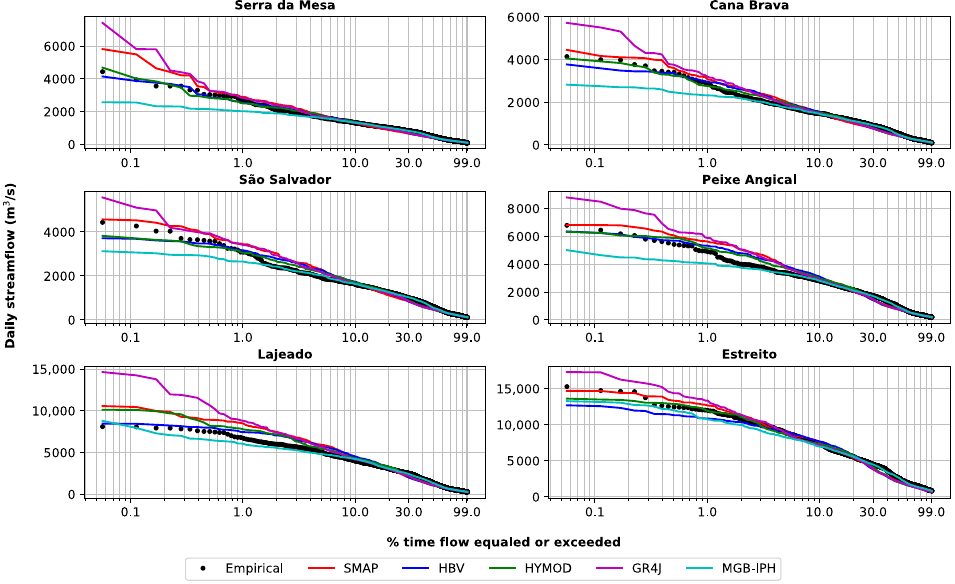
Figure 11. Curves describing the duration of daily streamflow in the Tocantins river basin for the validation period (2005–2010).